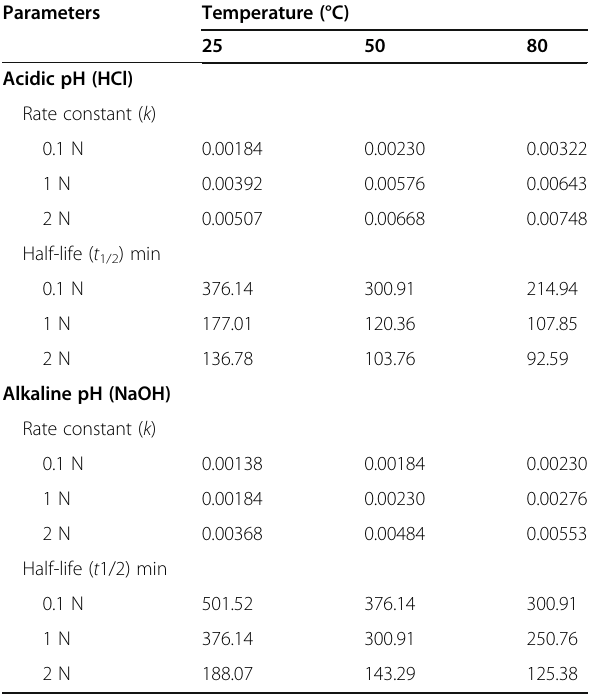
Table 3 Half-life ( t 1/2 ) and rate constant ( k ) at different pH and